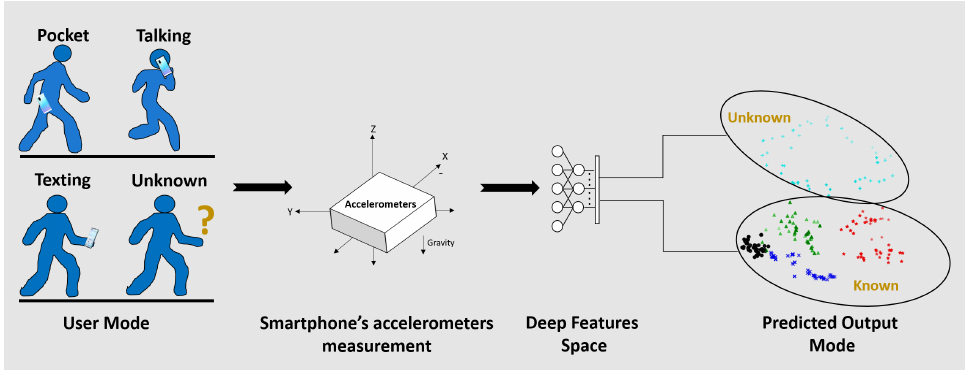
Figure 1. Proposed approach: accelerometer readings are represented in deep feature space to classify unknown smartphone